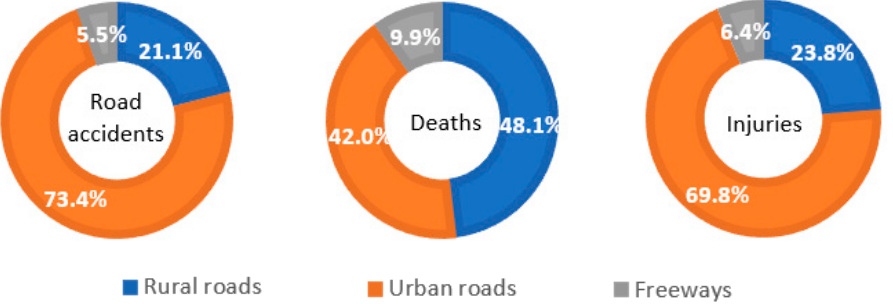
Figure 2. Road accidents, deaths and injuries for different road categories. Source: Italian National Institute of Statistics—Istat (2018).